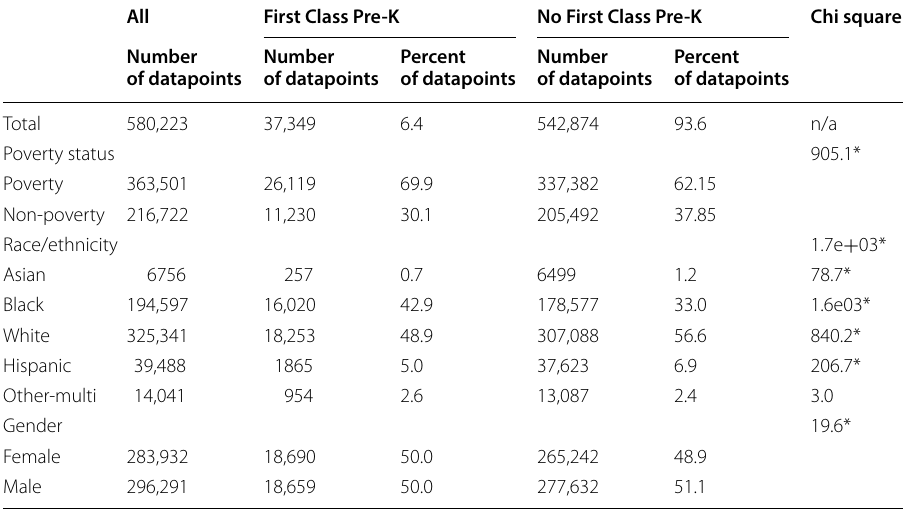
Table 2 Overall demographics of sample, 3rd–7th Grades; 2014/2015, 2015/2016, 2016/2017 school